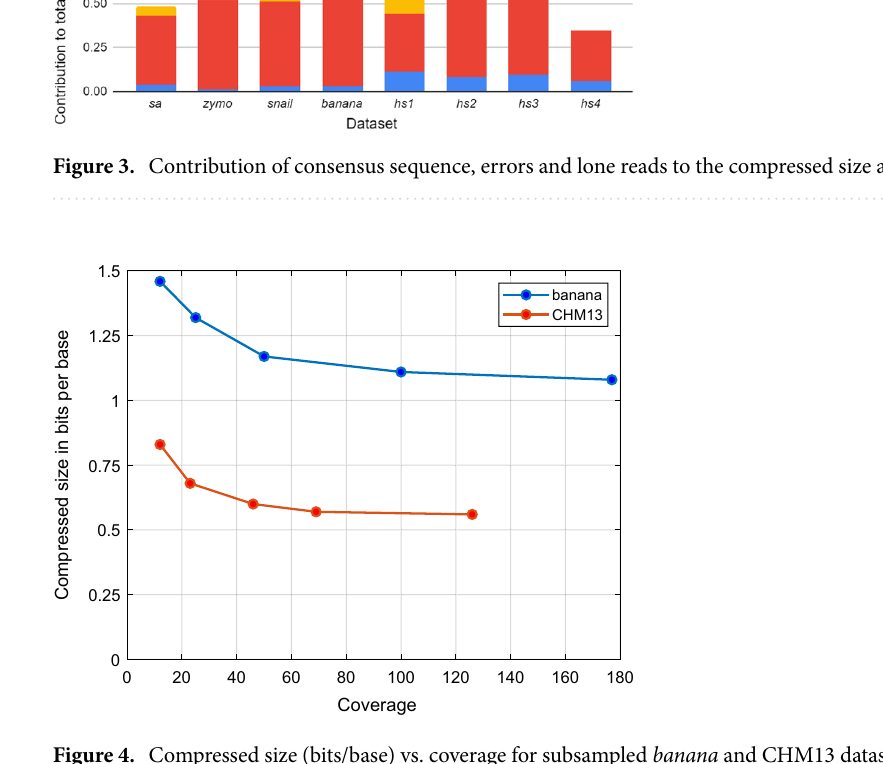
Figure 4. Compressed size (bits/base) vs. coverage for subsampled banana and CHM13 datasets.